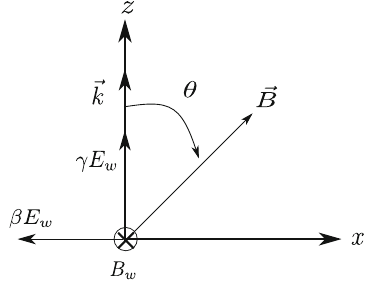
Fig. 1 Plane wave electromagnetic fields with the electric component γ E w (ξ) arising in the ˆ z direction, due to the nonlinear interaction. The uniform magnetic field background is shown making a θ angle with the z -axis.The magnitude of the fields is not on